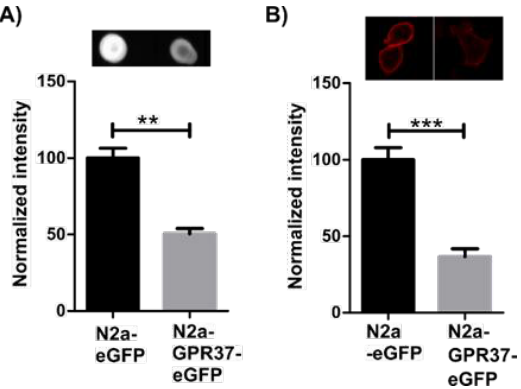
Figure 1. Quantification of total GM1 levels in stable N2a GPR37-eGFP and N2a eGFP detected with Cholera Toxin subunit B (CtxB)-Alexa 647 in dot blot, showing reduced levels of GM1 in N2a GPR37-eGFP compared to N2a eGFP . Representative image and data analyzed using t -test, n = 3 ( A ). Fluorescent imaging and quantification of plasma membrane fraction of GM1 bound to CtxB-Alexa 647 in red in stable N2a GPR37-eGFP and N2a eGFP . A total of 53 cells from three independent experiments was analyzed using non-parametric Mann – Whitney test. ( B ) Data are normalized to fluorescent intensity of N2a eGF . Results presented with means and error bars indicate SEM, ** p < 0.01, *** p < 0.001.